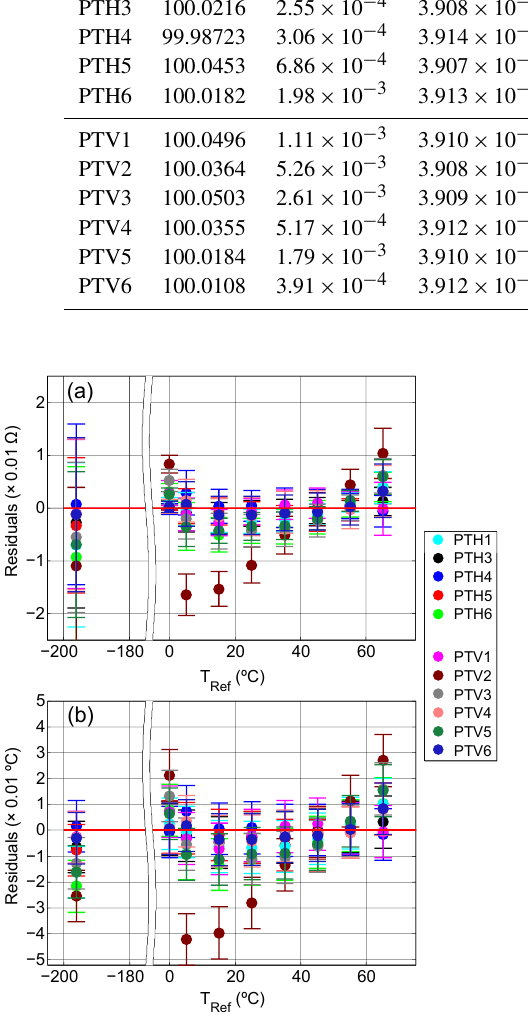
Figure A2. Residuals of the least squares fits to the CVD equation (Eq. A1 and Table A1), for the horizontal (PTH) and vertical (PTV) calibration strings versus temperature: (a) resistance residuals and (b) temperature residuals. The data were obtained during the labo- ratory calibration, July 2014.